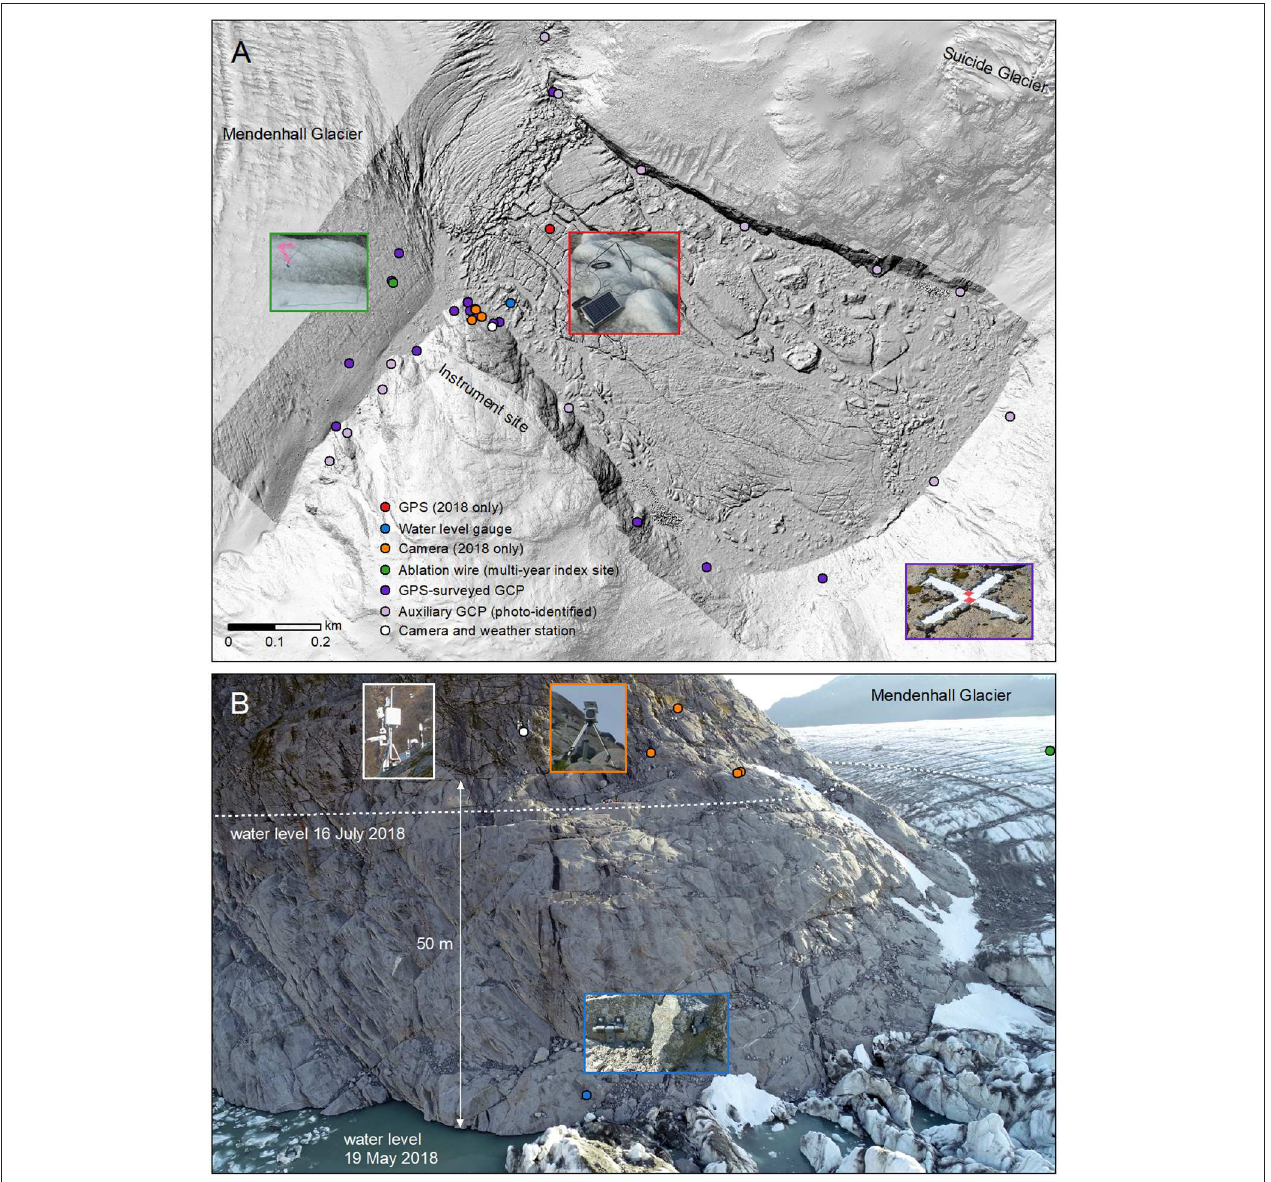
FIGURE 4 | (A) Overview map of Suicide Basin, featuring location of deployed instruments as color-coded points. Color-coded photos show the instruments used. The background map consists of a shaded relief DEM based on UAV imagery from 17 July 2018 ( ∼ 24 h after peak level). Outside the domain of the UAV DEM, laser data from 29 April 2018 completes the shaded relief DEM. (B) Aerial photo of the instrument site at the basin entrance. The photo was captured on 19 May 2018. Peak water level from 16 July 2018 is annotated for reference, as are the locations of key instruments from (A)